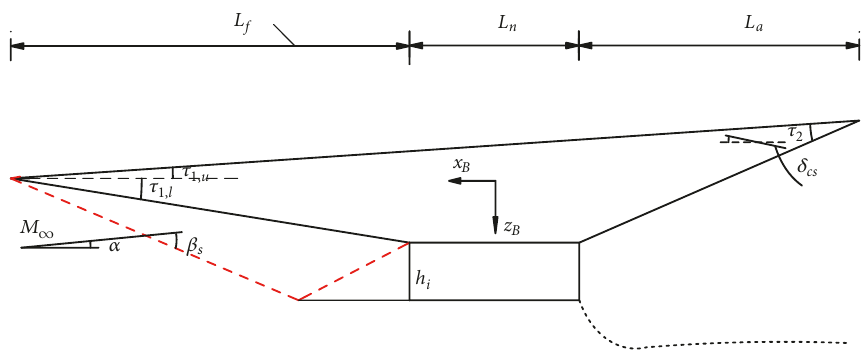
Figure 1: Representative shape of